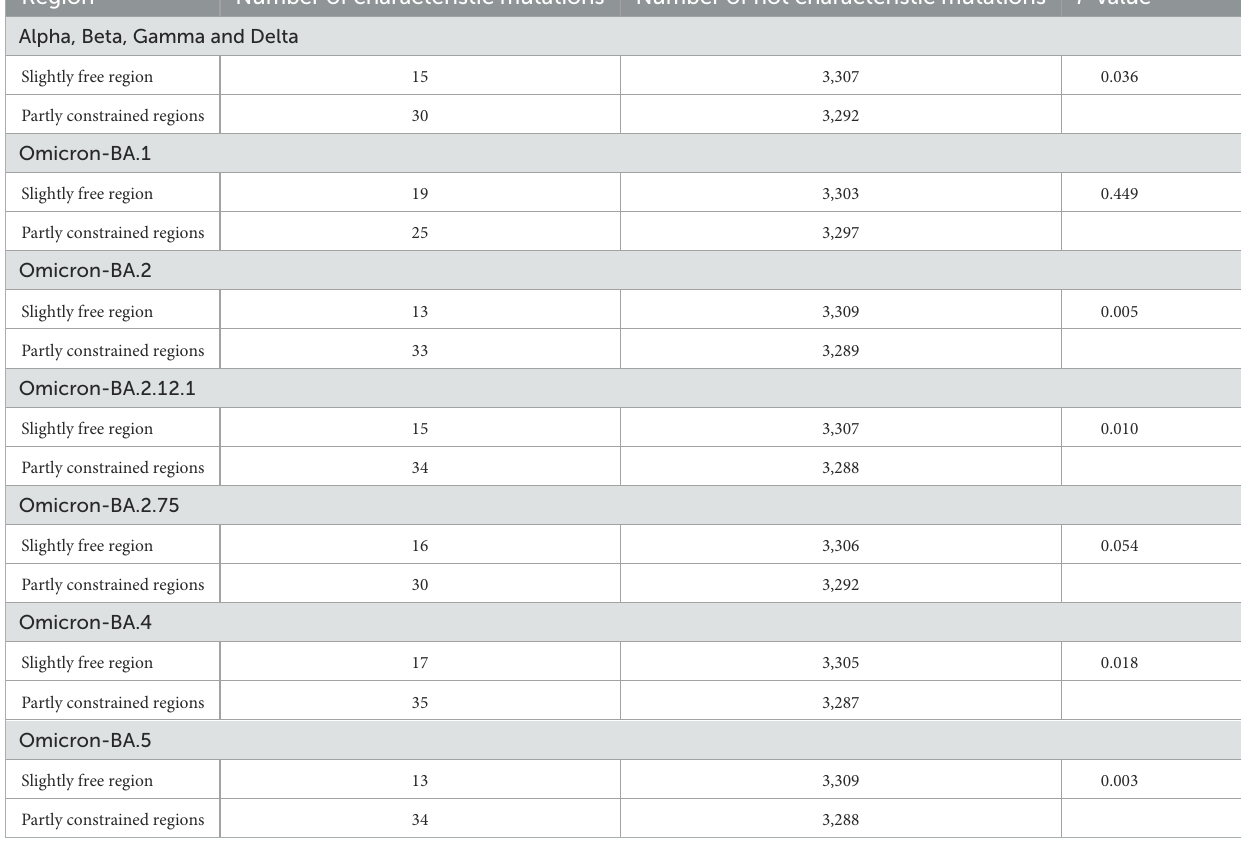
TABLE 1 Statistical test for positions of characteristic mutation accumulated in lineages. Region Number of characteristic mutations Number of not characteristic